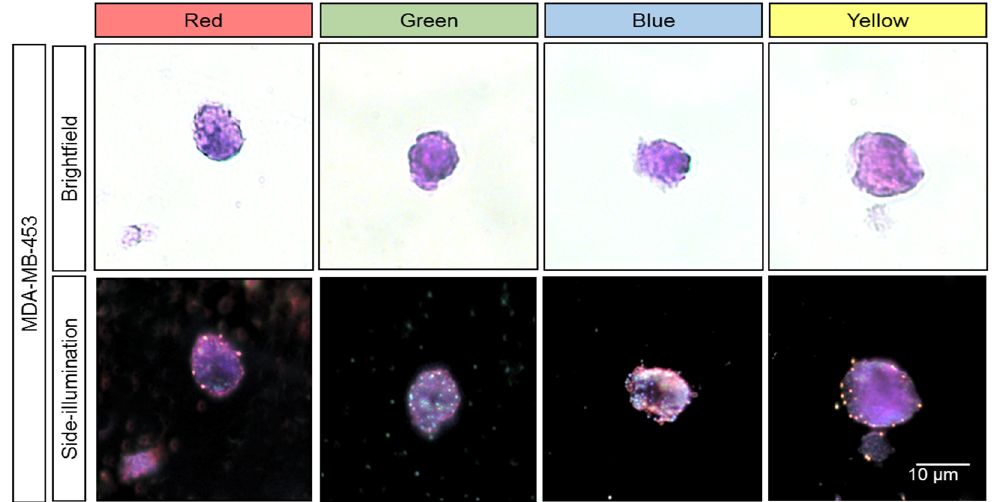
Figure 6. FFPE cells (MDA-MB-453) with H&E staining (Gill II hematoxylin and eosin B) observed with either bright-field or dark-field microscopy by using SI microscopy adaptor for visualizing red, green, blue, and yellow plasmonic NPs.